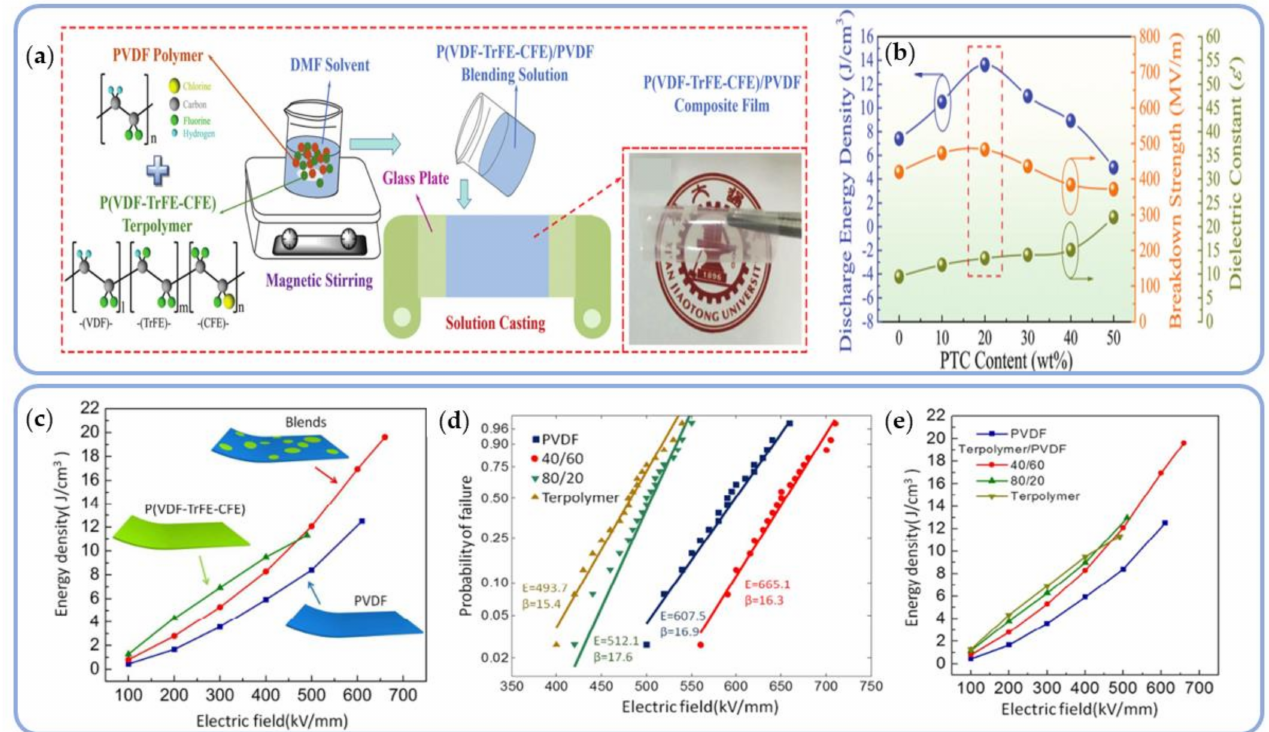
Figure 6. ( a ) Schematic diagram of PTC/PVDF preparation process and a photograph of the PVDF blended with 20 wt% PTC; ( b ) Contrast curve of discharge energy density, electric field intensity and dielectric constant; reprinted with permission from [88]. Copyright (2020), Royal Society of Chemistry. ( c ) Energy density comparison curve of blends, PVDF and P(VDF-TrFE); ( d , e ) Weibull distribution comparison curve and maximum discharge energy density curve of different content terpolymers and PVDF; reprinted with permission from [89]. Copyright (2016), American Chemical